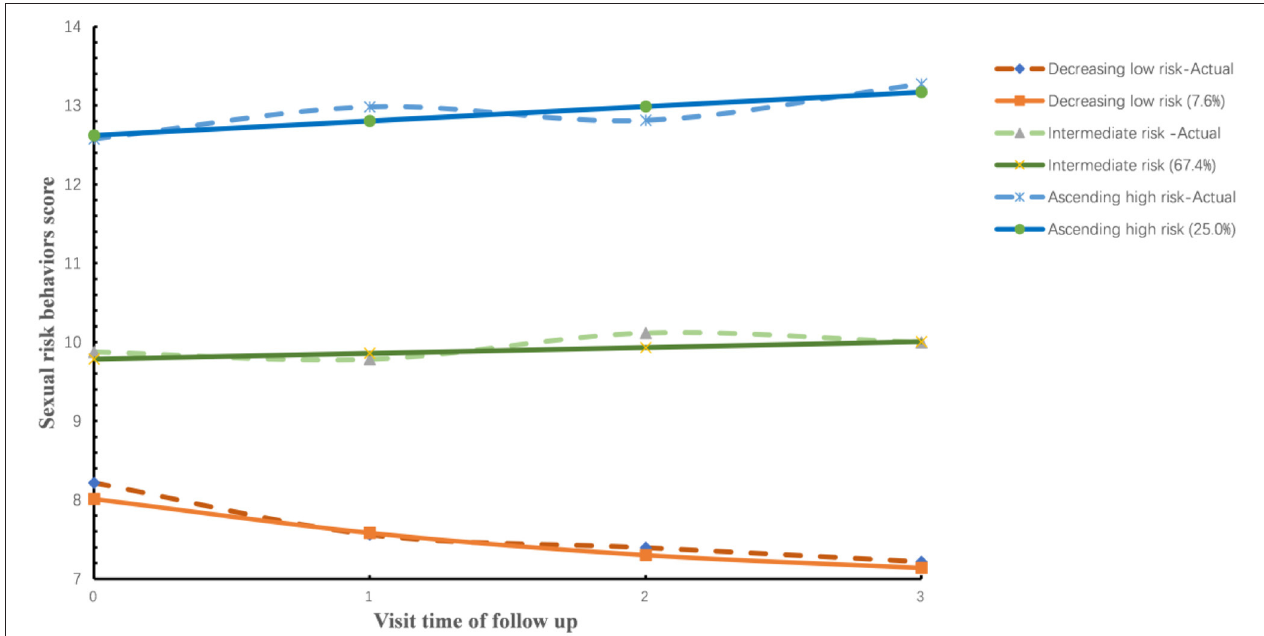
FIGURE 1 | Sexual risk trajectories among 460 HIV-negative participants (2017–2020). The solid lines indicate the predicted probabilities of sexual risk behaviors score based on membership in one of the three sexual risk behaviors trajectory groups, whereas the dotted lines indicate the actual sexual risk behaviors score based on group